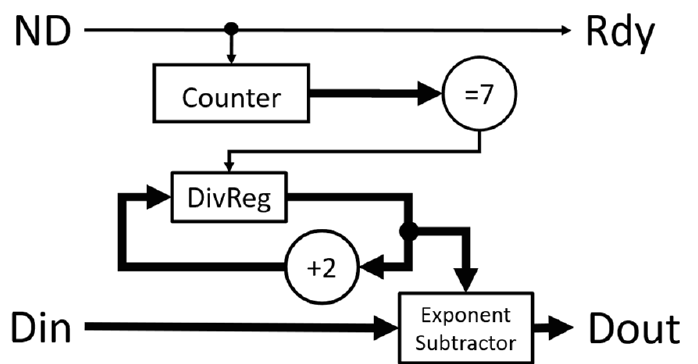
Figure 8. Functional block diagram of the scaler module. The input Din is a single-precision correlation value from the normalizer module. Dout is the final correlation value. Reset signal (not shown in the figure) clears all registers in the module.